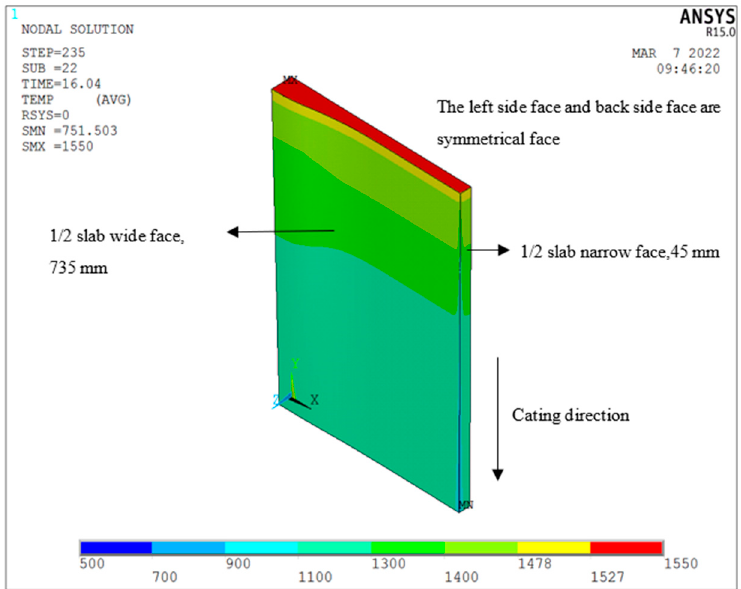
Figure 2. The 3D slab temperature field under typical conditions. From the results of the overall temperature field of the slab, it can be seen that the temperature of the molten steel surface of the mold is kept at the pouring temperature of 1550 ◦